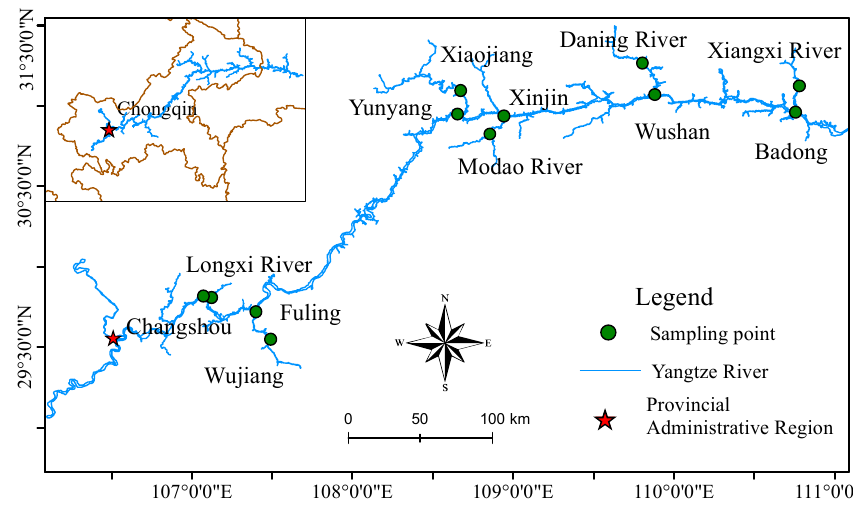
Figure 1. Spatial distribution of heavy metals in the surface sediments of the Three Gorges Reservoir.